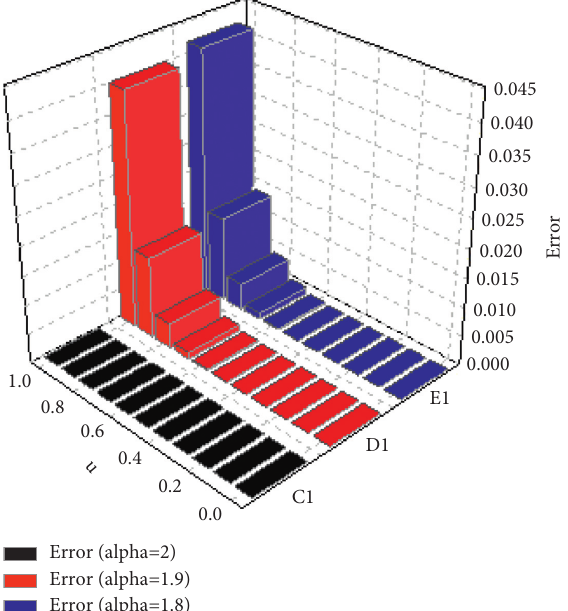
Figure 6: Error graph of MLWM and CPM for problem the solution for example 4.5 at different fractional orders is Table 9. Table 10 shows the error comparison of CPM and calculated. It is confirmed that the solution at various CWM at m � 6 which confirm that CPM converges quickly fractional order approaches towards the integer-order so- as compared to CWM. We illustrate the accurate and es- lution. The results of the presented method are better than timated solutions for m � 6 in Figure 11, while Figure 12 those of the CWM method for this problem. shows the error comparison of both methods. In Figure 13,